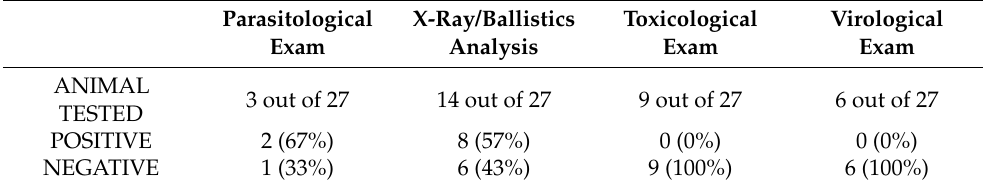
Table 2. Diagnostic tests performed and results. Parasitological X-Ray/Ballistics Exam Analysis